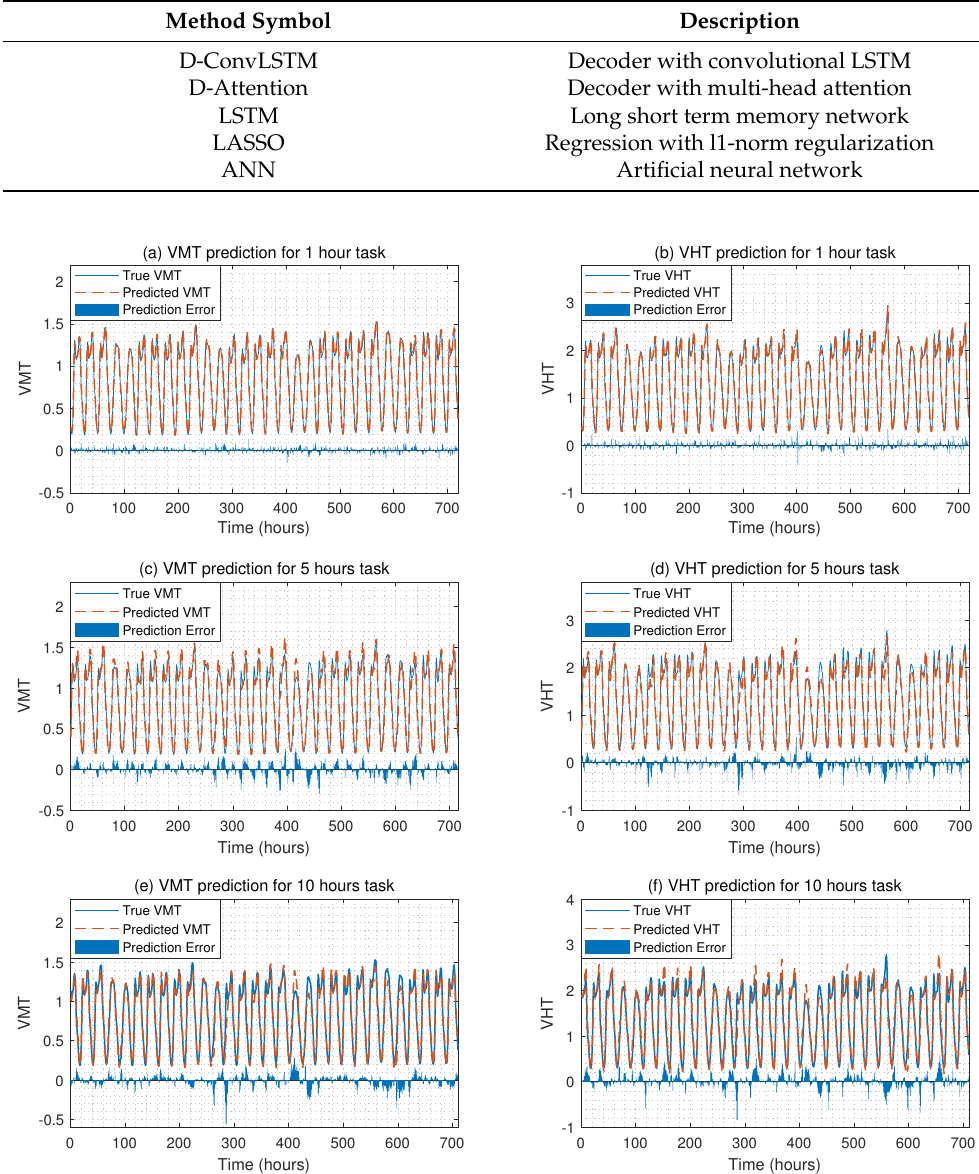
Figure 5. The VMT and VHT prediction results for three different tasks under the first case, where ( a , c , e ) show the VMT predictions for three tasks; and ( b , d , f ) show the VHT predictions for three